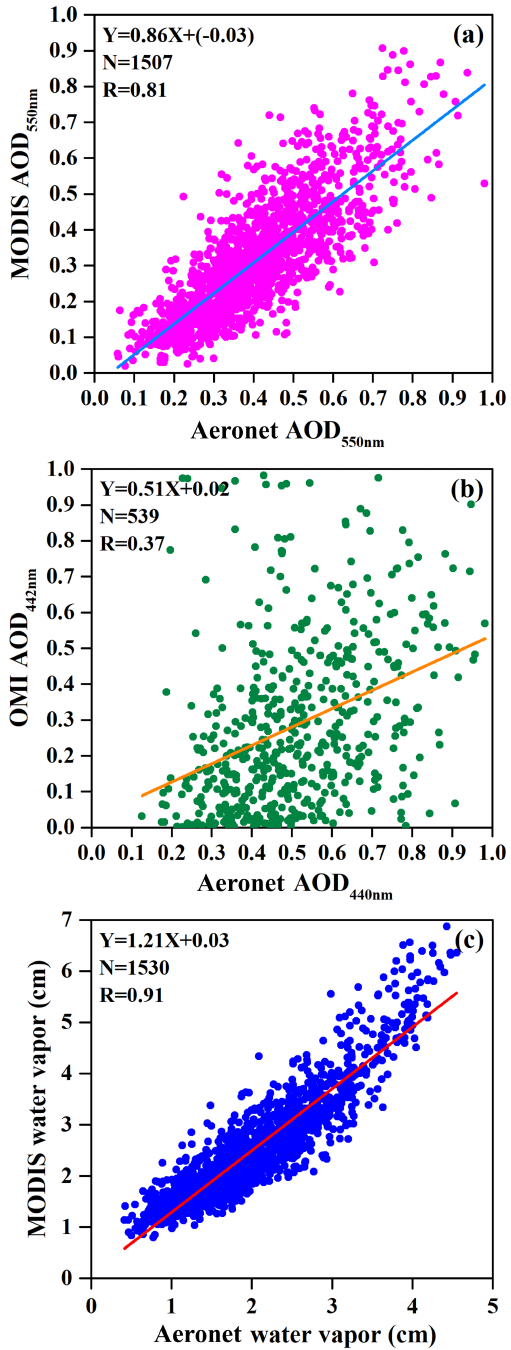
Figure 16. Correlation between (a) AERONET AOD at 550nm with MODIS AOD at 550nm, (b) AERONET AOD at 440nm with OMI AOD at 442nm and (c) AERONET water vapor (cm) with MODIS water vapor